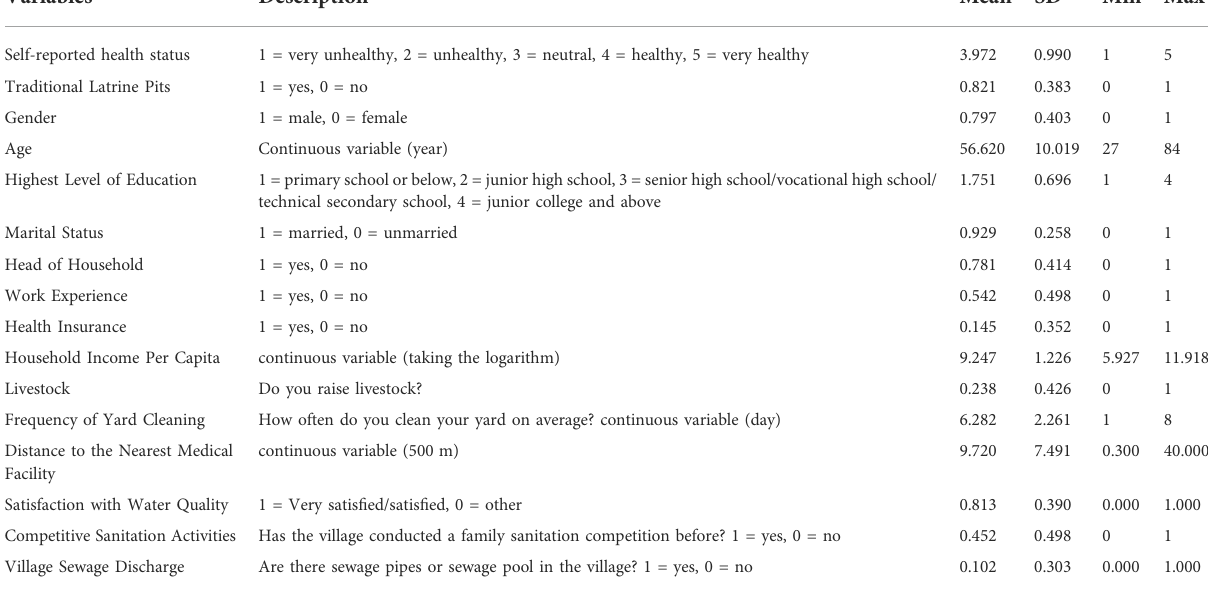
TABLE 1 Summary statistics.